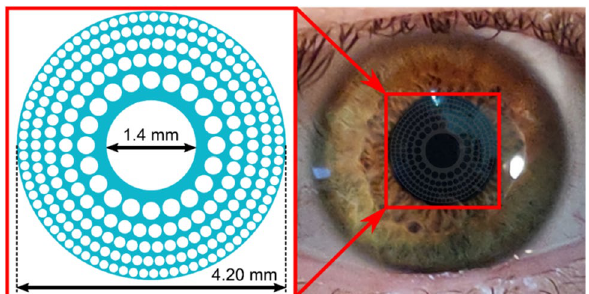
Figure 1. PDCI design. The blue areas in the left figure represent a biocompatible (transparent), hydrogel- based, material of refractive index of 1.458 (see “Methods” section for details). The image on the right is a simulation of the appearance of the PDCI (in stark contrast) on a real